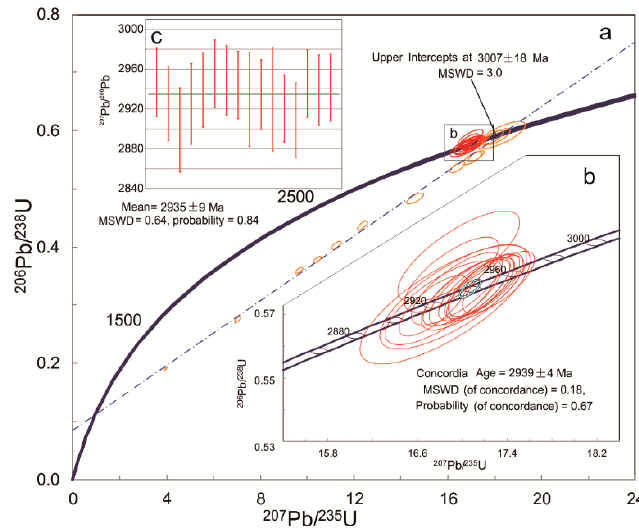
Figure 9. Zircon U–Pb concordia age diagrams for the trondhjemitic gneiss (D0002-3). ( a ) Diagram for 14 analytical spots that gave a discordia line with an upper intercept 207 Pb/ 206 Pb age of 3007 ± 18 Ma;